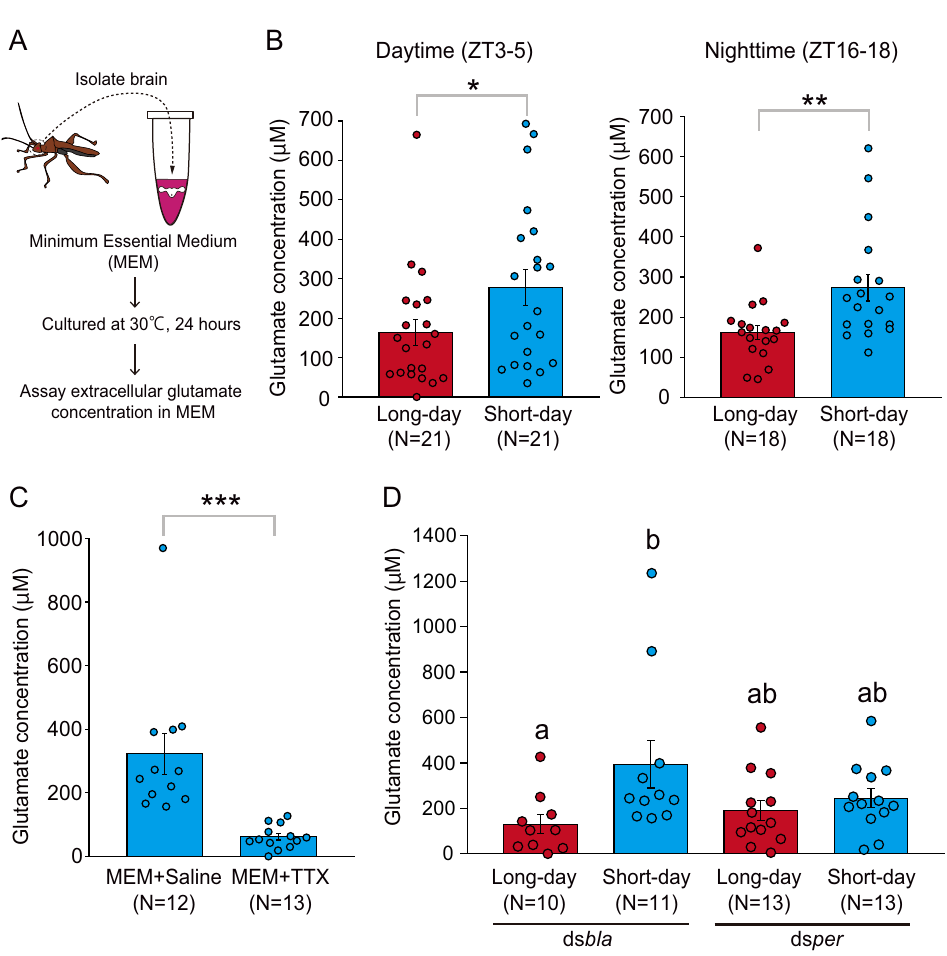
these enzyme-encoding genes can genetically manipulate extracellular glutamate levels under long-day and short-day conditions in the group-bred females. In the control ds bla group, there was a significant difference in glutamate concentration between long-day and short-day conditions (Fig 2A), which was similar to intact females (Fig 1B). On the other hand, females injected with dsRNA for got (ds got ) showed low glutamate levels under both long days and short days (Fig 2A). In contrast, glutamate concentration of dsRNA for gs (ds gs )-injected females was high in both long-day and short-day conditions (Fig 2A). Within both ds got and ds gs groups, there were no significant differences in glutamate concentration between long days and short days. These results indicated that RNAi of got induced a decrease in the brain